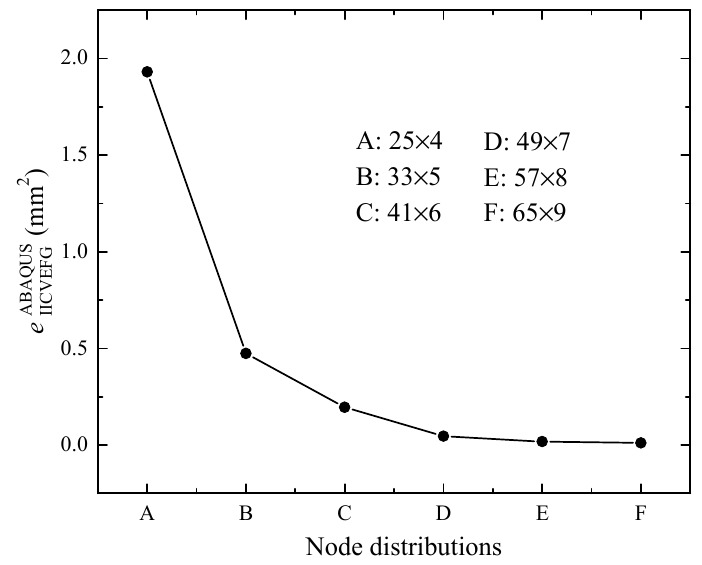
Figure 5. The error analysis under different node distributions.